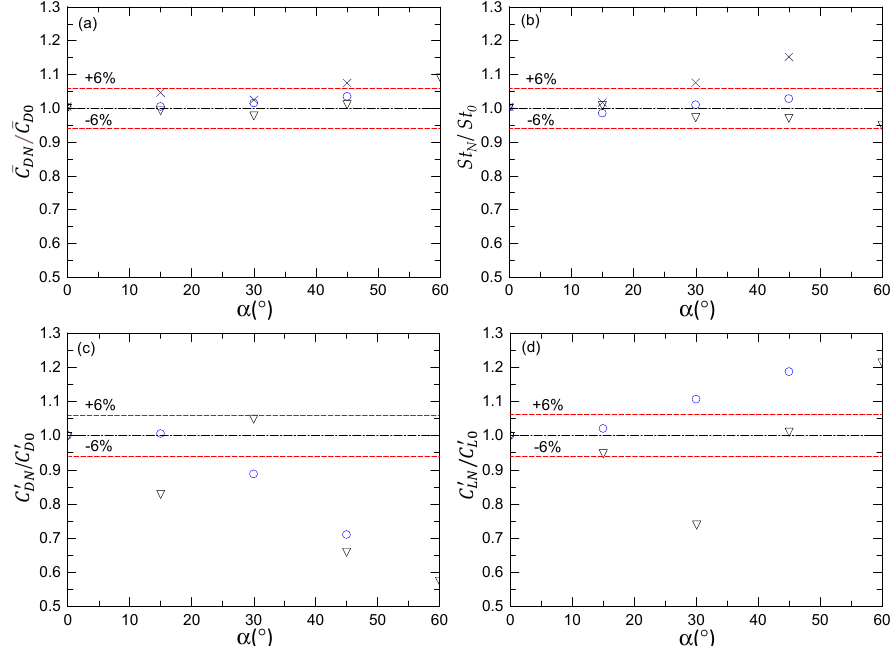
Figure 7. Ratios of force coefficients and Strouhal number at various cylinder yaw angles with those at α = 0°. ( a ) 𝐶̅ (cid:3005)(cid:3015) /𝐶̅ (cid:3005)(cid:2868) ; ( b ) St N / St 0 ; ( c ) 𝐶 (cid:3005)(cid:3015)(cid:4593) / 𝐶 (cid:3005)(cid:2868)(cid:4593) ; ( d ) 𝐶 (cid:3013)(cid:3015)(cid:4593) / 𝐶 (cid:3013)(cid:2868)(cid:4593) . The dashed lines denote ±6% tolerances. The dash–dotted lines denote a ratio of 1. : Present study, square cylinder; : Lou et al. [19], square cylinder; : Zhao et al. [10], circular cylinder.